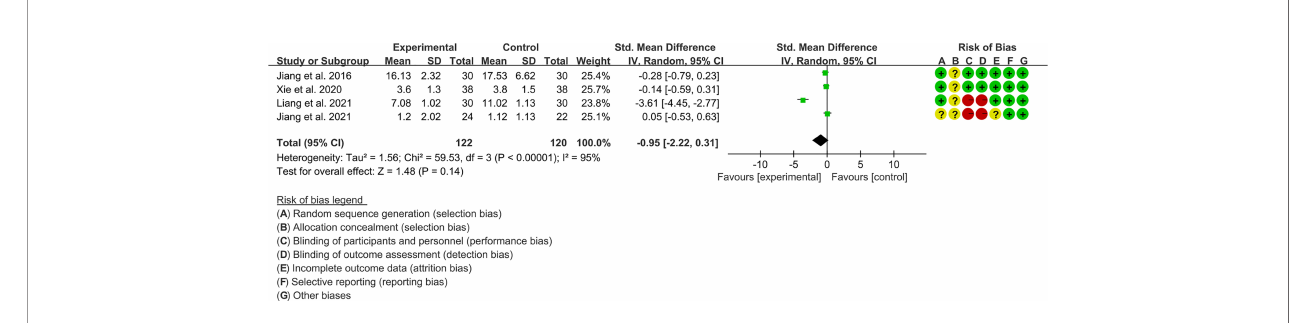
FIGURE 8 | The results of CRP.